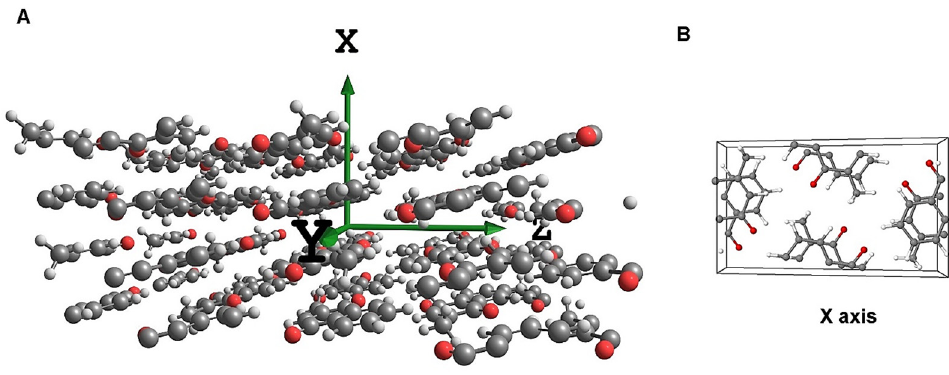
Figure 6. ( A ): Molecular structure of crystalline menadione used in this study; ( B ): the content of the unit cell, perspective Figure 6. A : Molecular structure of crystalline menadione used in this study; B : the content of the view along the unit cell, perspective view along the x-axis.